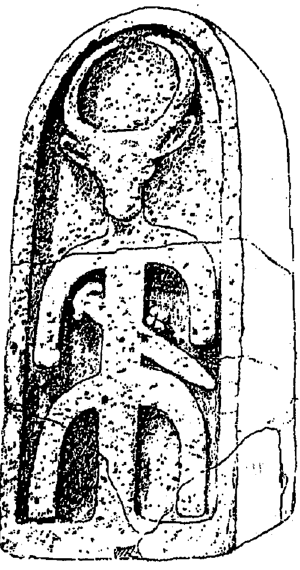
Figure 8. Stele from the gate area of Bethsaida from (Keel 1998, fig. 107). Note the bull head and horns that form a crescent moon.